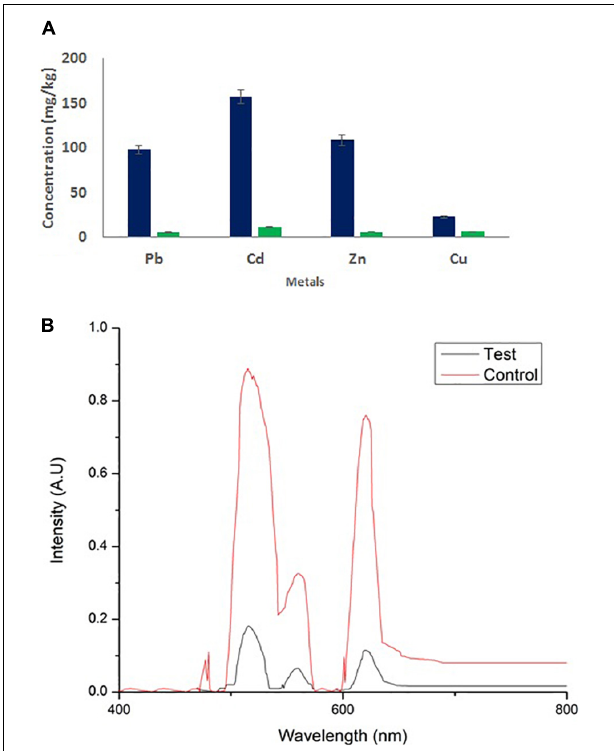
FIGURE 9 | (A) Atomic absorption spectroscopy and (B) UV/Vis analysis of wastewater and its heavy metal remediation using MSI 54